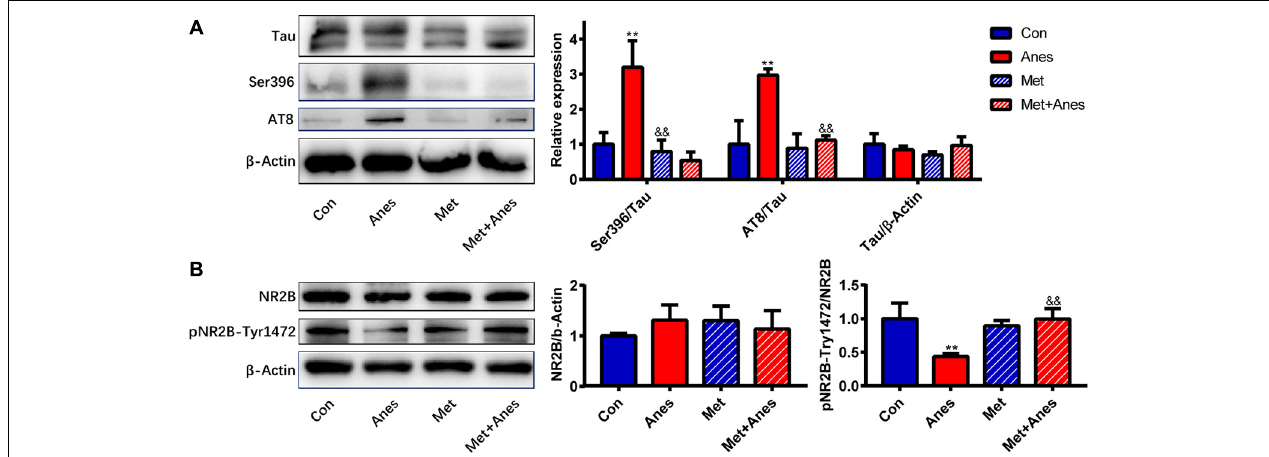
FIGURE 4 | Metformin alleviates tau hyperphosphorylation and pNR2B-Tyr1472 downregulation caused by long-term isoflurane anesthesia. Representative western blots (left panels) and densitometric analysis (right panels, n = 3 mice per group) showing the effects of isoflurane anesthesia (Anes group), metformin (Met group), and anesthesia plus metformin pretreatment (Met + Anes group) on expression levels of total tau (Tau) and phosphorylated tau (Ser396 and AT8) (A) , as well as total NR2B (NR2B) and phosphorylated NR2B at Tyr1472 (pNR2B-Tyr1472) (B) in the hippocampus. β -Actin was used as a gel loading control. Data are expressed as mean ± SD and compared by one-way ANOVA followed by Bonferroni multiple comparisons tests. ∗∗ P < 0.01 compared to the Con group; && P < 0.01 compared to the Anes